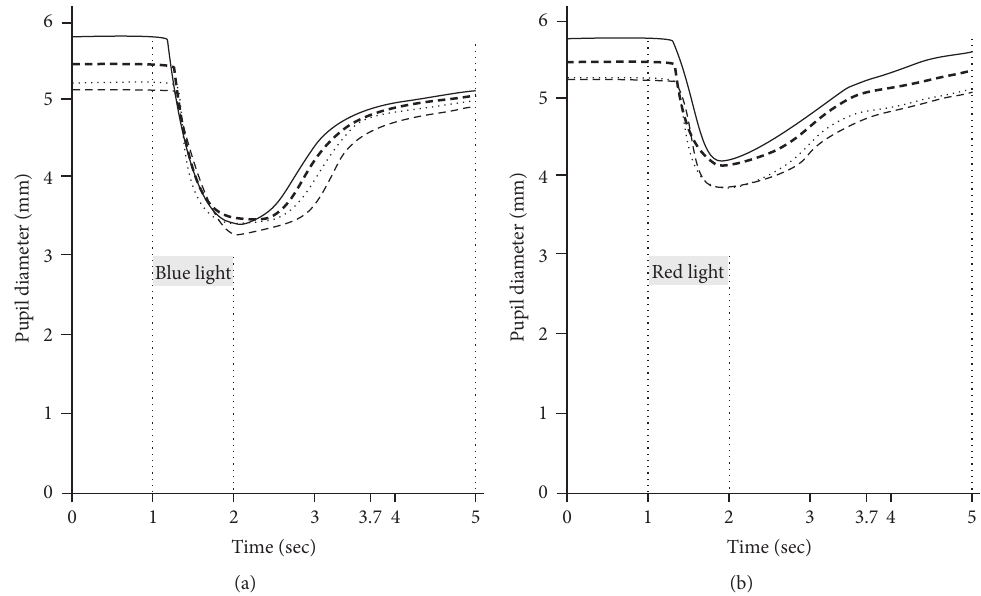
Figure 3: Comparison of average pupillary light reflex waveform on blue light (a) and red light (b) exposure between controls (—) and diabetic subgroups { I; without neuropathy ( ------ ), II; asymptomatic neuropathy ( ⋅⋅⋅⋅⋅⋅⋅⋅ ), and III; symptomatic but without diabetic autonomic neuropathy (---) } stratified by the severity of